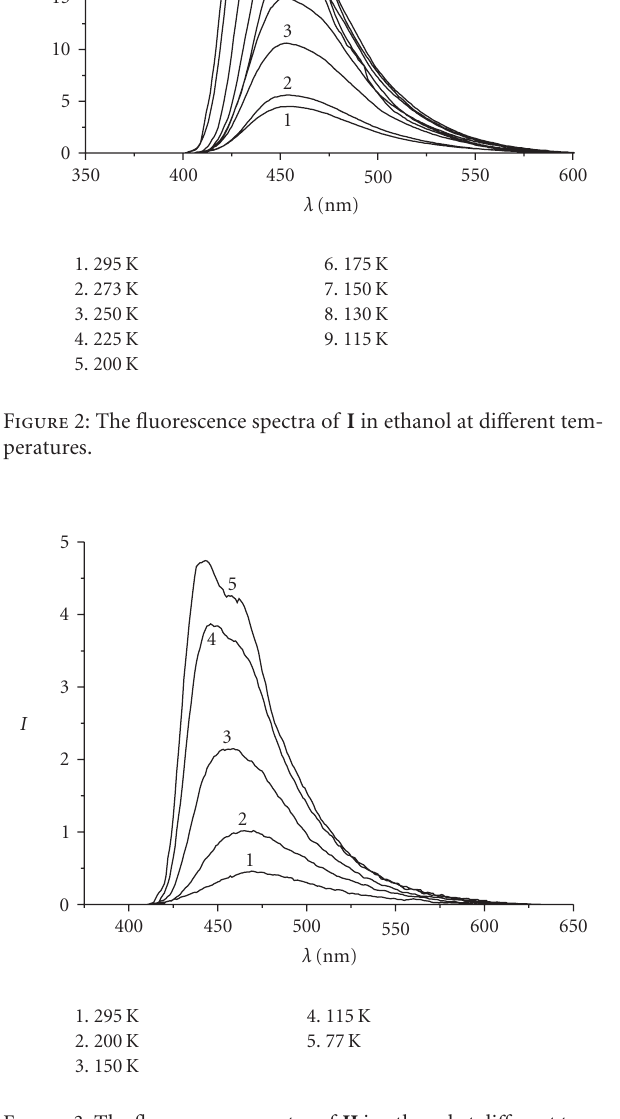
Figure 5: The fluorescence spectra of IV in ethanol at di ff erent tem-